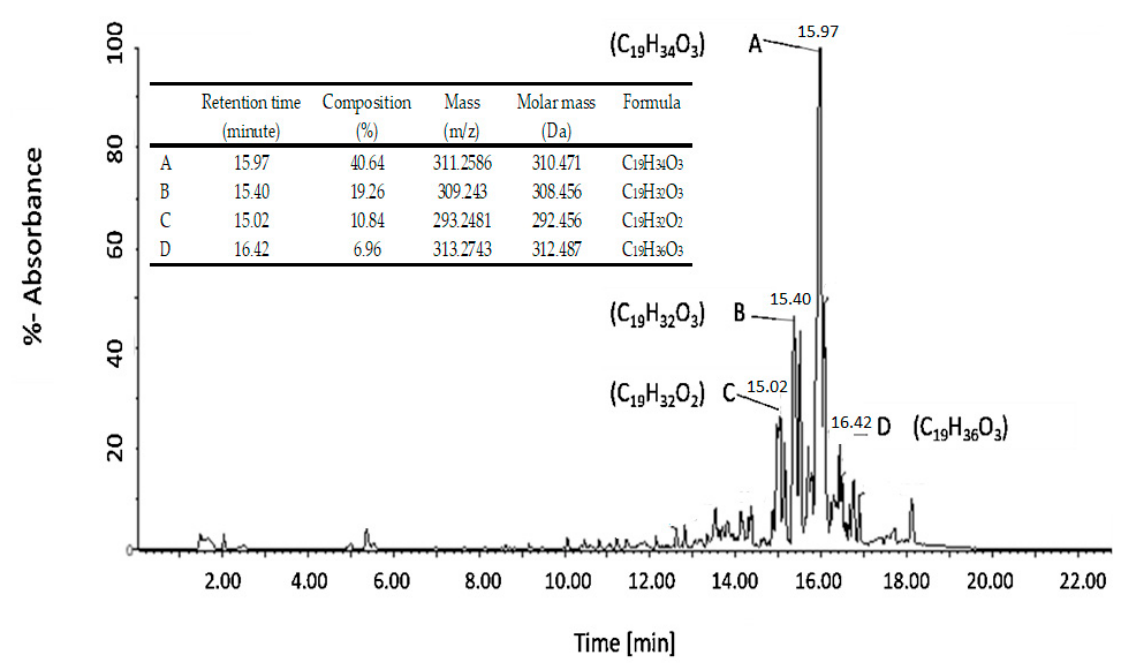
Figure 5. LC-MS analysis of biosurfactant from H. Meridiana BK-AB4.